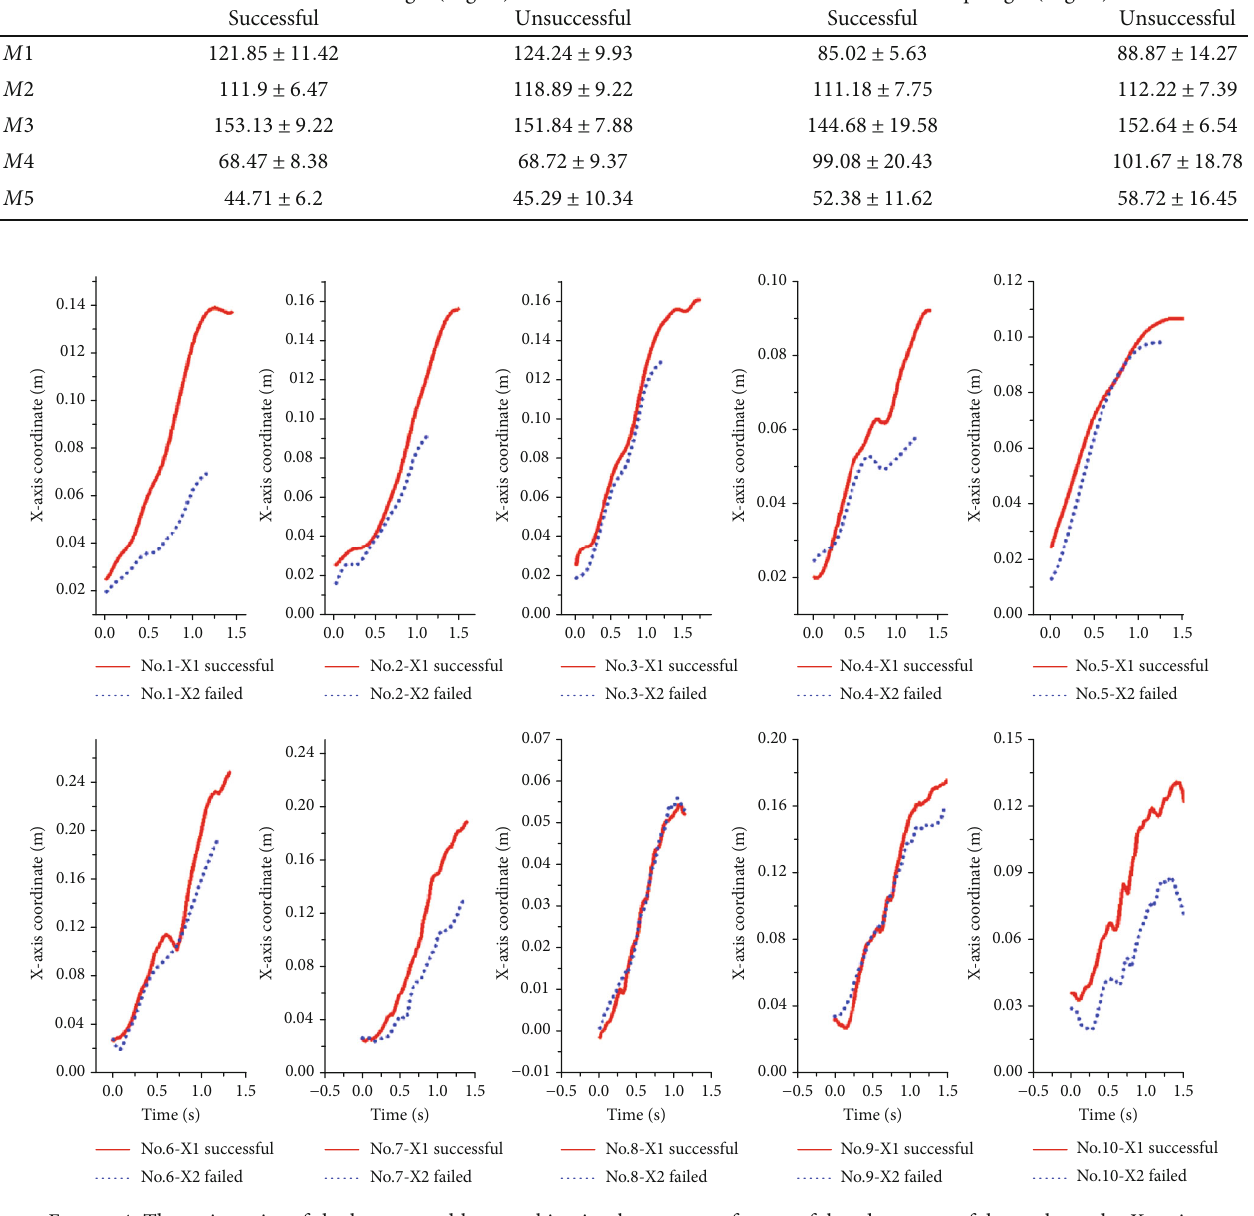
Figure 4: The trajectories of the human and bar combination barycenter of successful and unsuccessful snatch on the X -